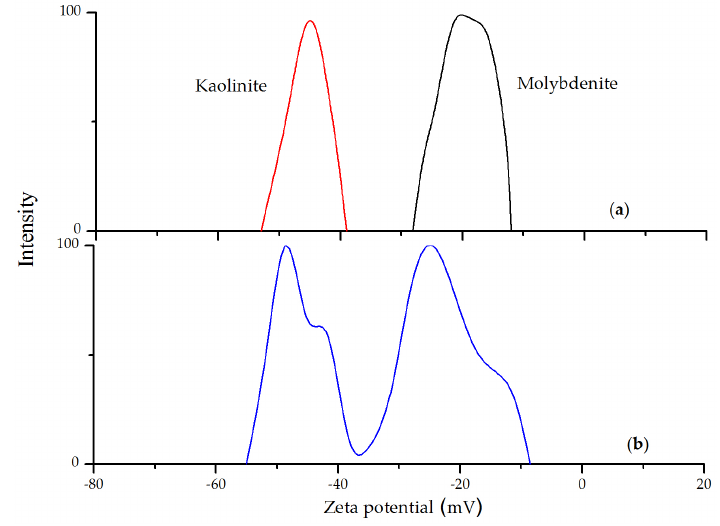
Figure 7. Zeta potential distributions in distilled water with 1 mM KCl; ( a ) Individual; ( b ) Mixture.